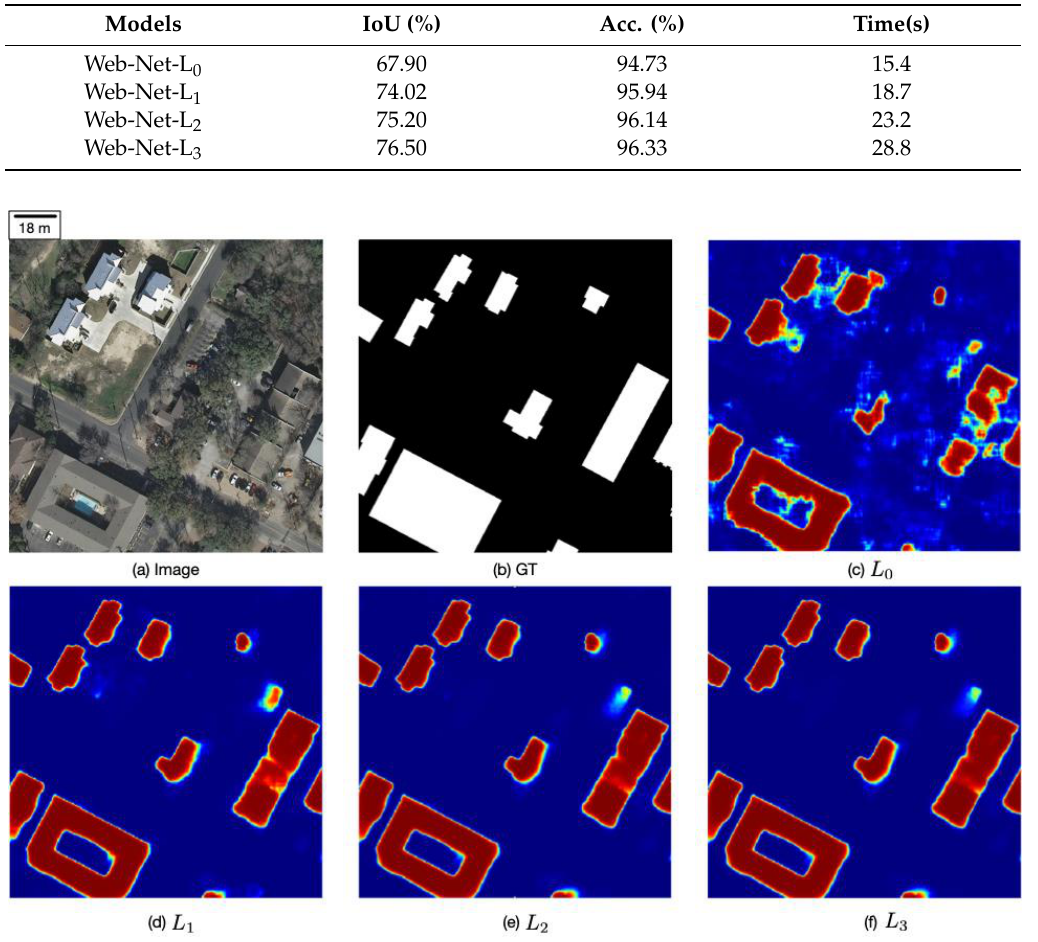
Figure 9. Comparison of the heat maps from di ff erent nodes in level 0. ( a ) is the original image, ( b ) is the ground truth, and ( c – f ) are the heat maps from di ff erent output